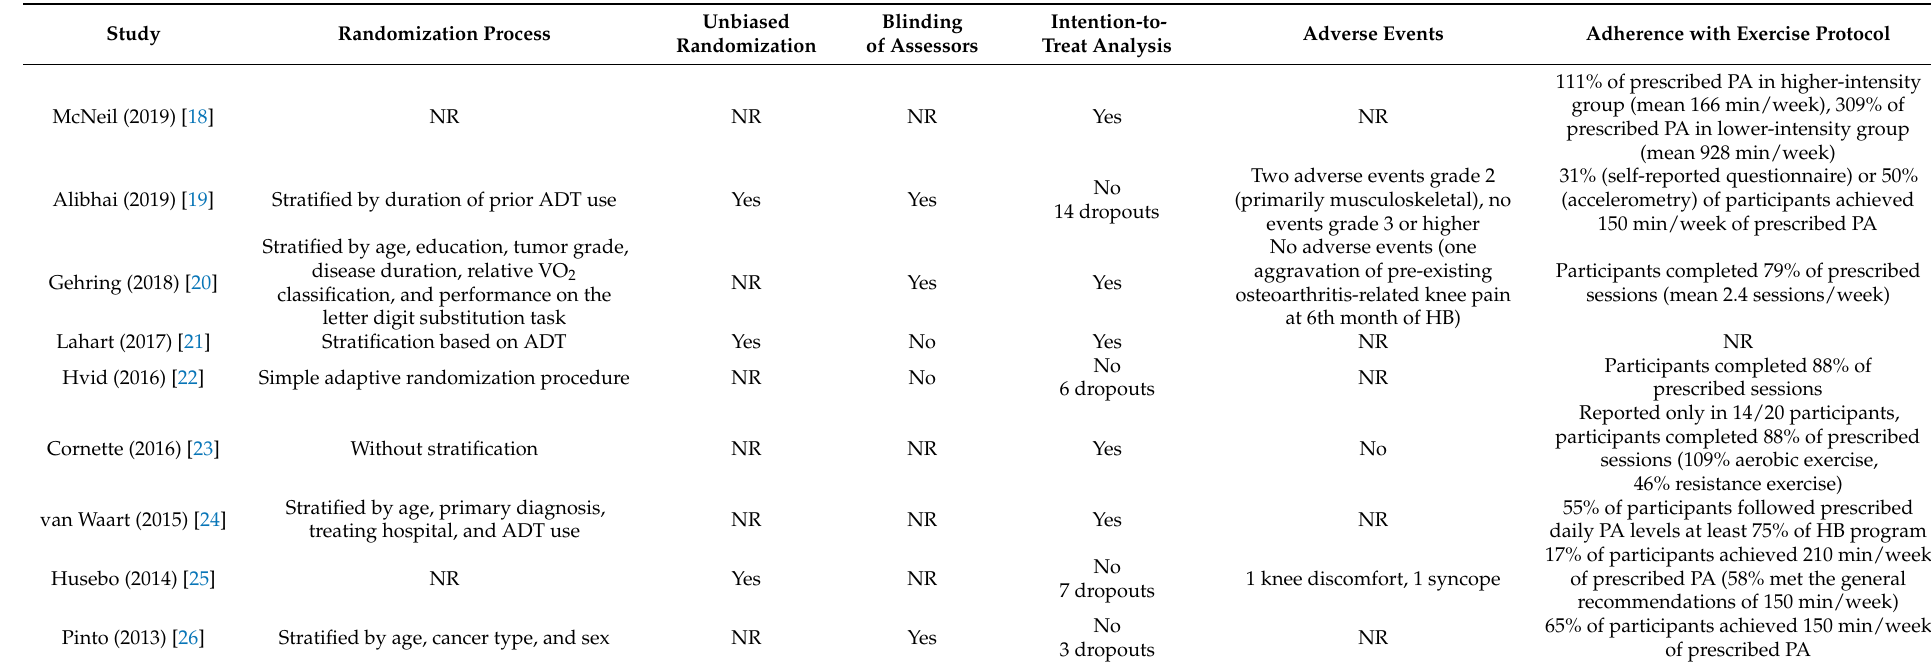
Table 2. Methodological quality of studies that have evaluated the effects of home-based exercise intervention on cancer